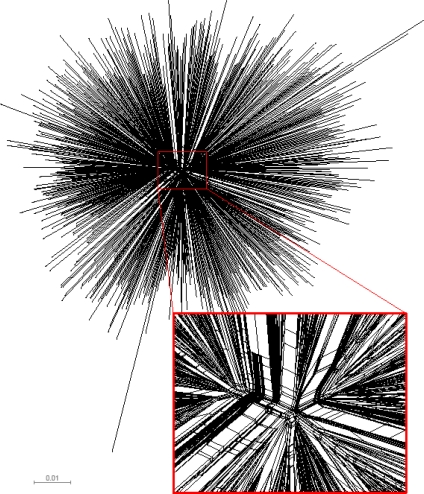
Phylogenetic network of HIV-1 subtype C gag sequences (n=653). The presented split network was generated by SplitsTree v4 [32,33] using the NeighborNet approach. To highlight multiple splits and parallel branching, the central part of the split network is enlarged.